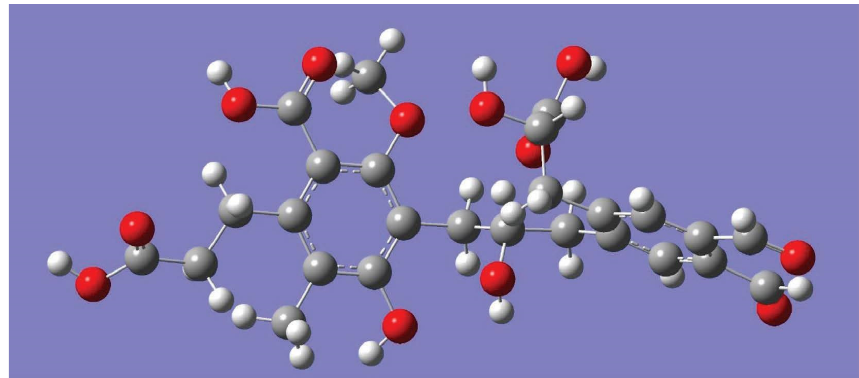
Figure 1: Hypothetical model structures of humic matter of aquatic